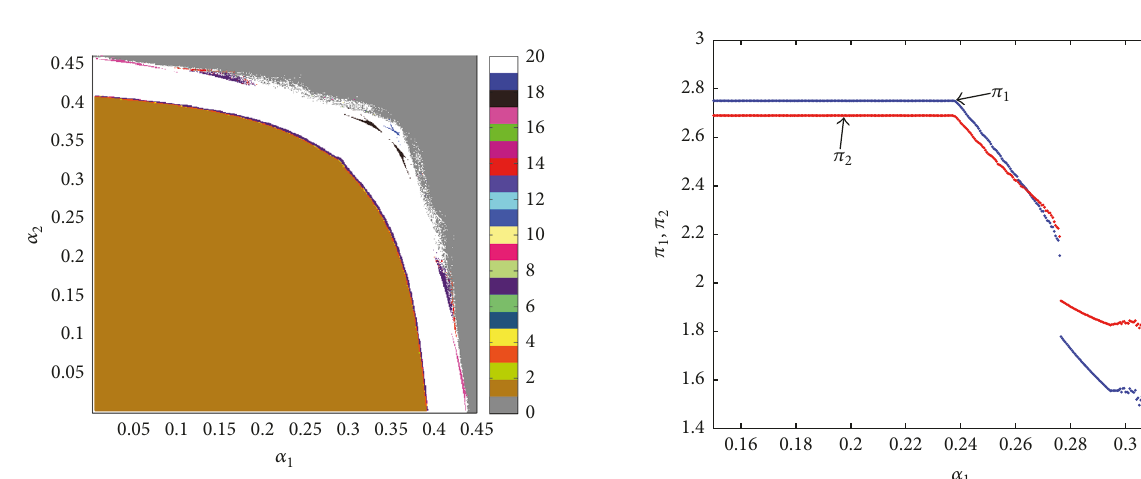
Figure 6: Parameter basin in (𝛼 1 , 𝛼 2 ) plane when 𝜃 = 0.6 , 𝛼 = 0 , and 𝑤 𝑖 = 0.5 .